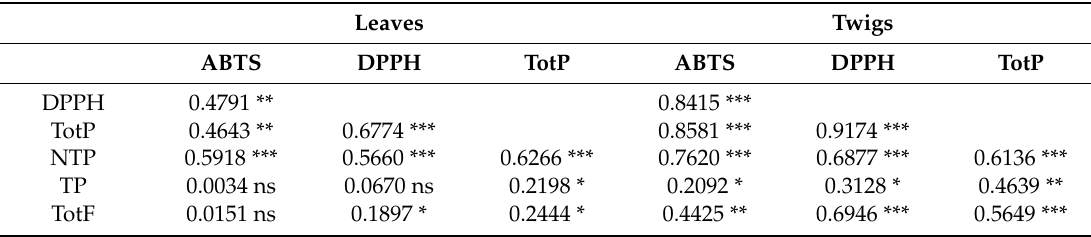
Table 3. Correlations (R 2 ) established between total phenolics (TotP), non-tannic phenolics (NTP), tannic phenolics (TP), total flavonoids (TotF) and antioxidant capacity (ABTS, DPPH) in leaves and twigs of the examined accessions of Parthenium argentatum harvested at 30 (winter) and 33 months (spring) after transplanting. Leaves Twigs ABTS DPPH TotP ABTS DPPH TotP DPPH 0.4791 ** 0.8415 *** TotP 0.4643 ** 0.6774 *** 0.8581 *** 0.9174 *** NTP 0.5918 *** 0.5660 *** 0.6266 *** 0.7620 *** 0.6877 *** 0.0034